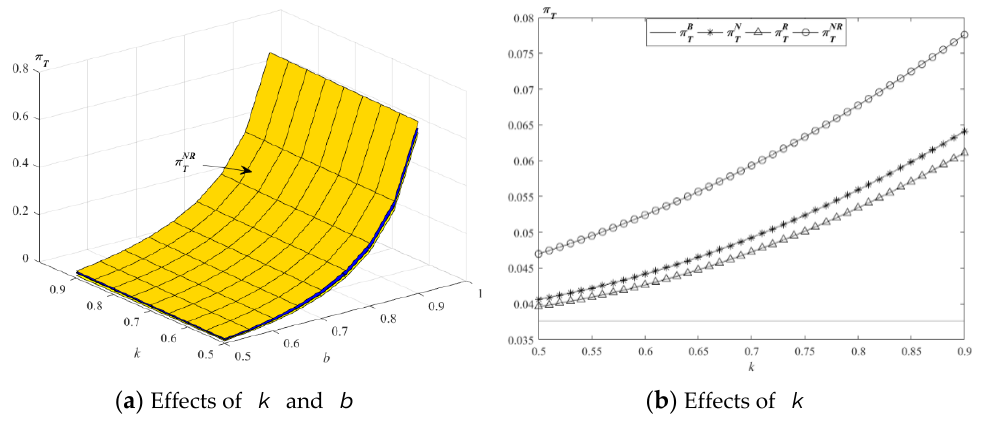
Figure 8. Impact of k and b on the optimal profit of CLSC.